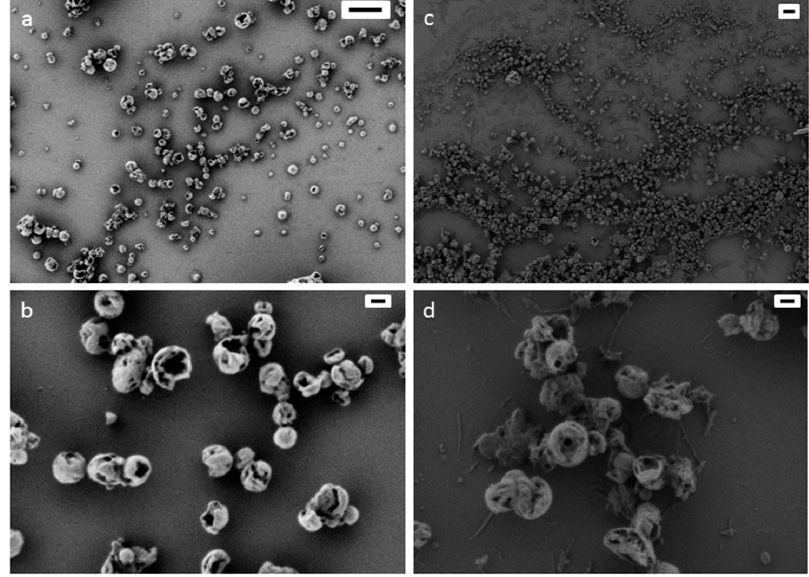
Figure 3. SEM images of polyurea (PU) nanocapsules before (( a ) scale bar 1 μ m; ( b ) scale bar 100 nm) and after redispersion (( c ) scale bar 1 μ m; ( d ) scale bar 100 nm) into 0.1 wt % SDS solution.